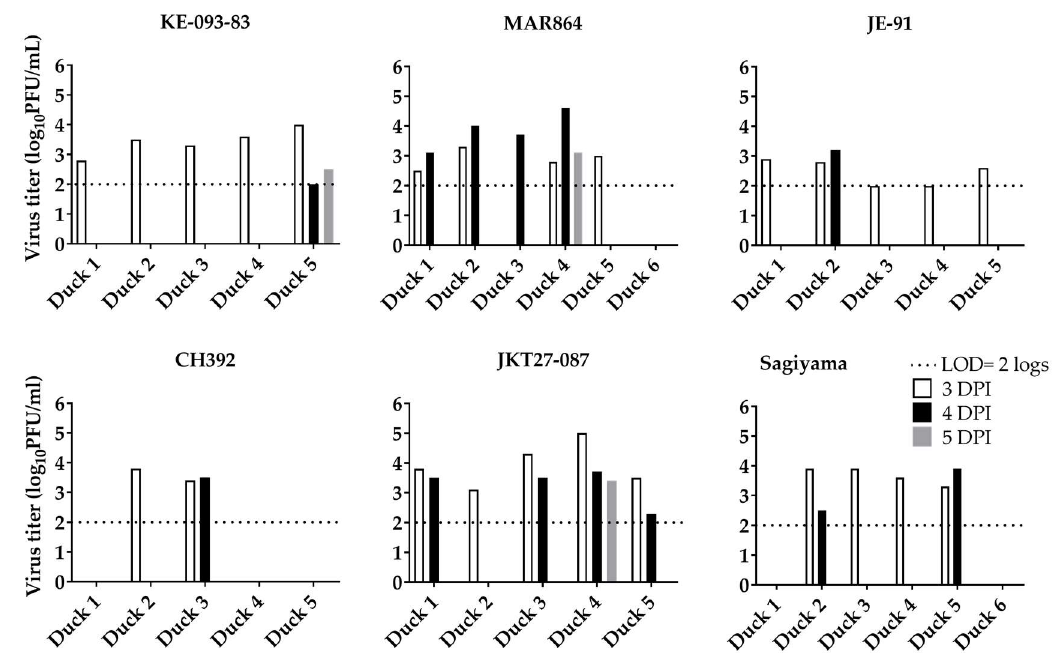
Figure 5. Oral shedding of Japanese encephalitis viruses from ducklings . Duckling 6 for both MAR864 and Sagiyama groups were non-inoculated controls.